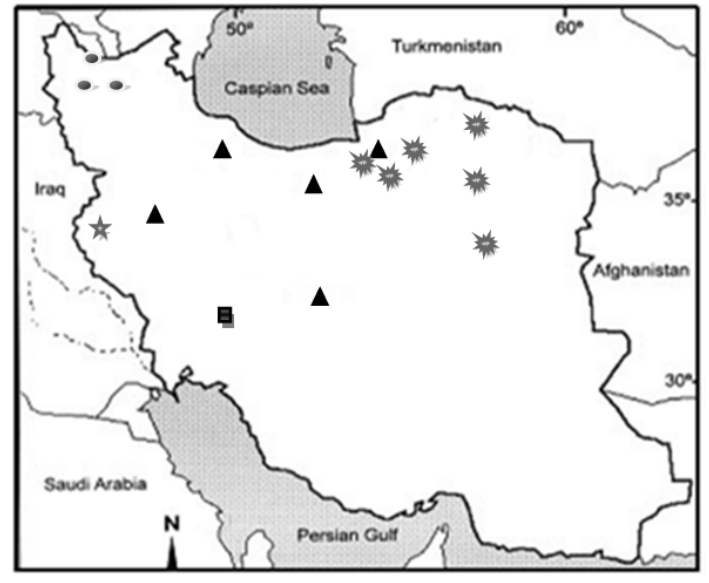
Fig. 1. Distribution map of A. lanceolatum ( ), A. mulleri ( ▲ ), A. persicum ( ■ ), A. baumgartnerianum ( ● ) and A. lepidoto-stellatum ( ✶